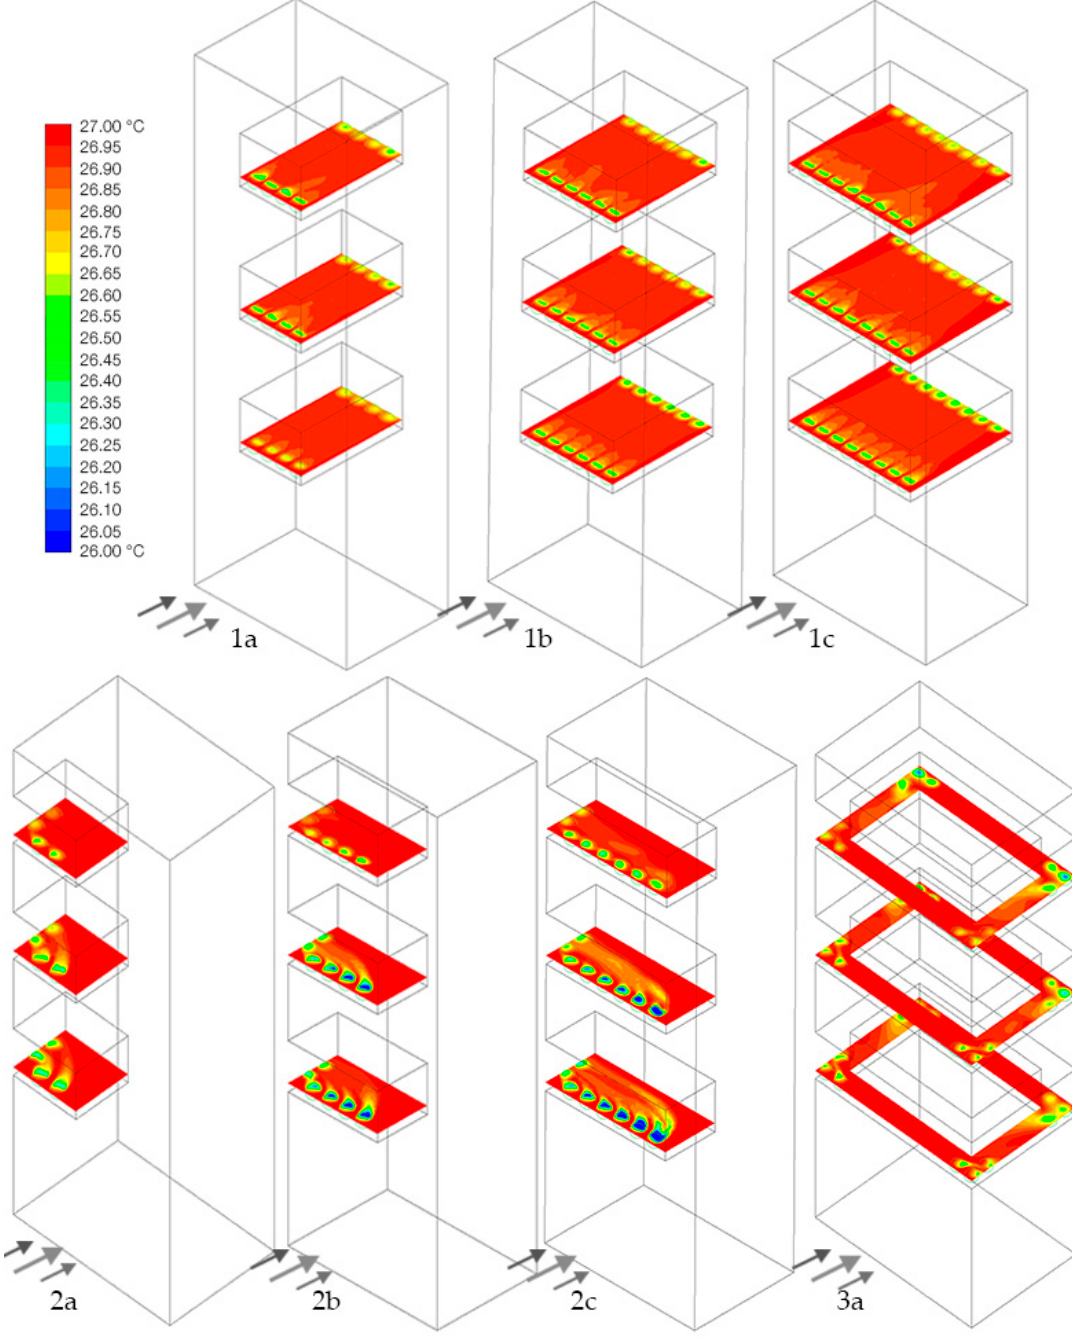
Figure 14. Temperature contour in the sky garden with trees, at a height of 1.4 m; (1a) Central sky garden b/B = 0.4, (1b) Central sky garden b/B = 0.6, (1c) Central sky garden b/B = 0.8, (2a) Corner sky garden b/B = 0.4, (2b) Corner sky garden b/B = 0.6, (2c) Corner sky garden b/B = 0.8, (3a) Periphery sky garden a/A = 0.5.